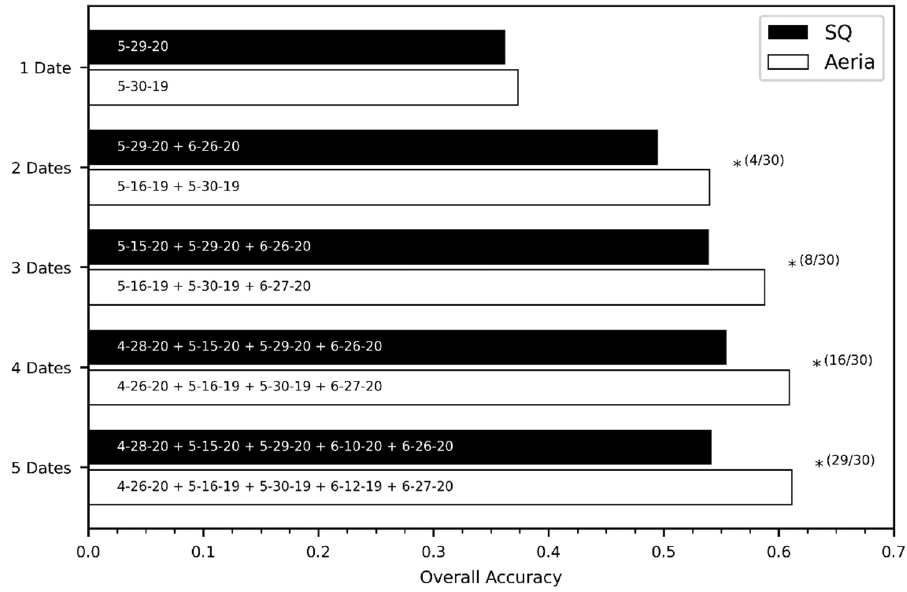
Figure 5. Comparison between the best performing Aeria and Sequoia combinations, indicated on the label, within each combination group. The asterisk (*) indicates at least one statistically significant comparison at the 95% confidence level over 30 iterations. The value in parenthesis presents the number of iterations in which the pairing was significantly different.